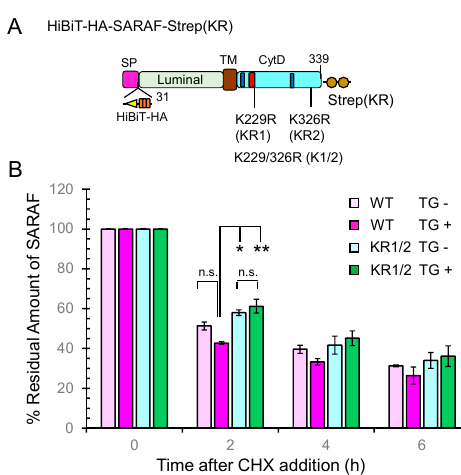
Figure 8. Slowdown of SARAF protein degradation rate by Lys-to-Arg substitutions in the CytD. ( A ) Schematic diagram of full-length SARAF that was tagged with HiBiT and 3xHA (designated HiBiTHA) between the signal peptide (SP) and the N -terminus of mature SARAF and tagged at the C-terminus with the Lys-to-Arg-substituted twin Strep (designated Strep(KR). ( B ) The half-life assays were repeated three times as described in Materials and Methods and the results are expressed as 100% at the 0 time for each condition. Data are expressed as mean ± SEM ( n = 3). Statistical significance by Tukey’s test is indicated by asterisks (* p < 0.05; ** p < 0.01). n.s., not significant. CHX, cycloheximide; TG, thapsigargin.